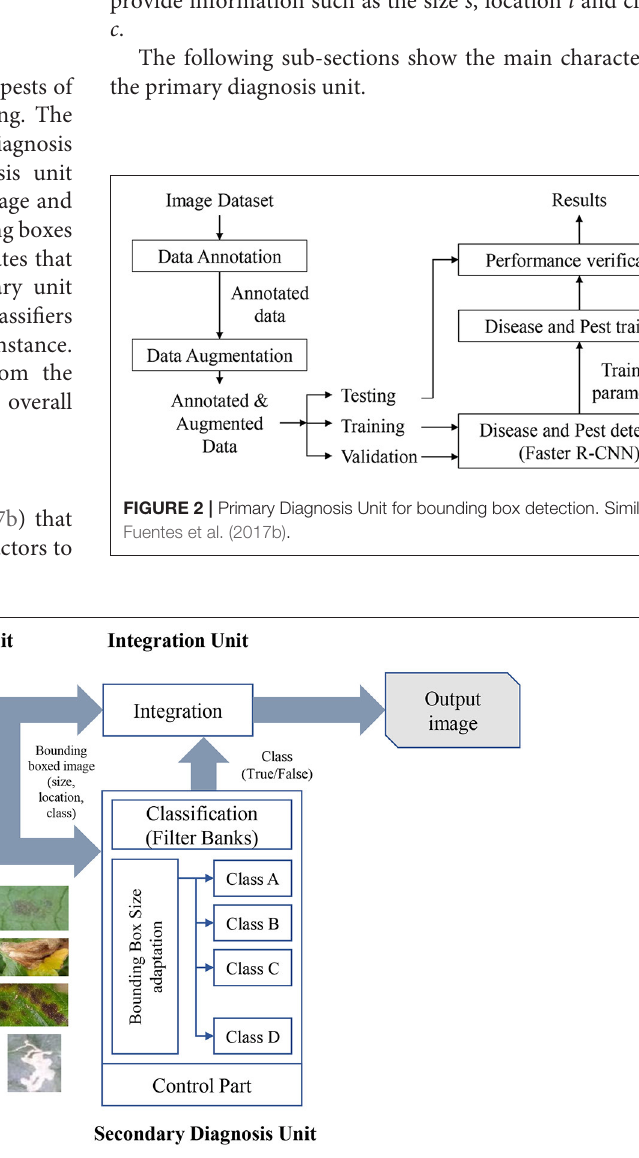
Frontiers in Plant Science |